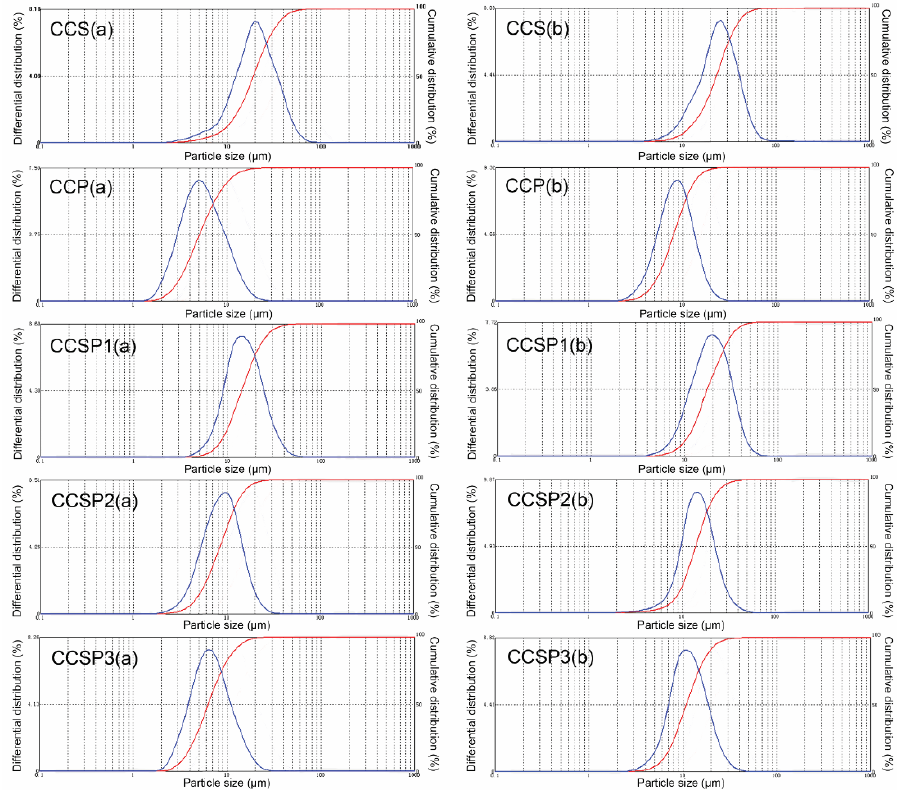
Figure 6. Particle size distribution of samples by using ( a ) ethyl alcohol or ( b ) distilled water as the dispersion medium.